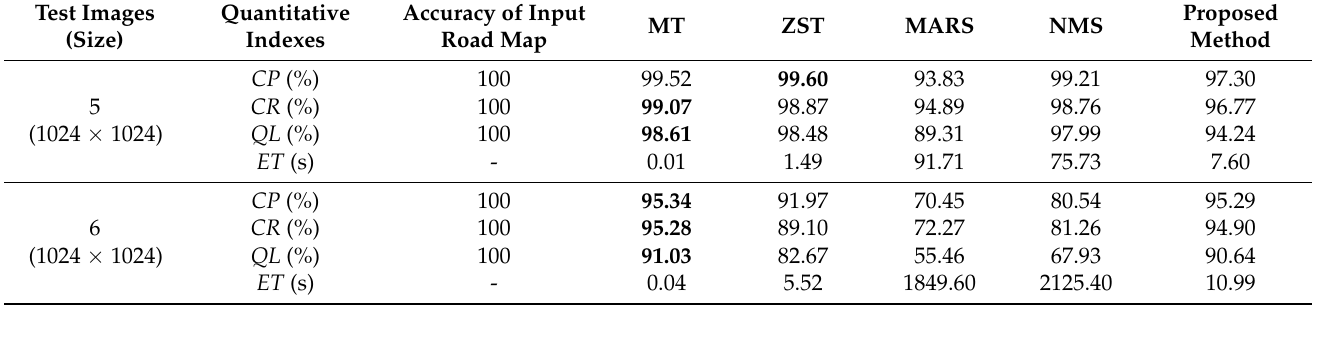
Table 4. Quantitative indexes of centerline extraction in test images 5 and 6 with different methods.